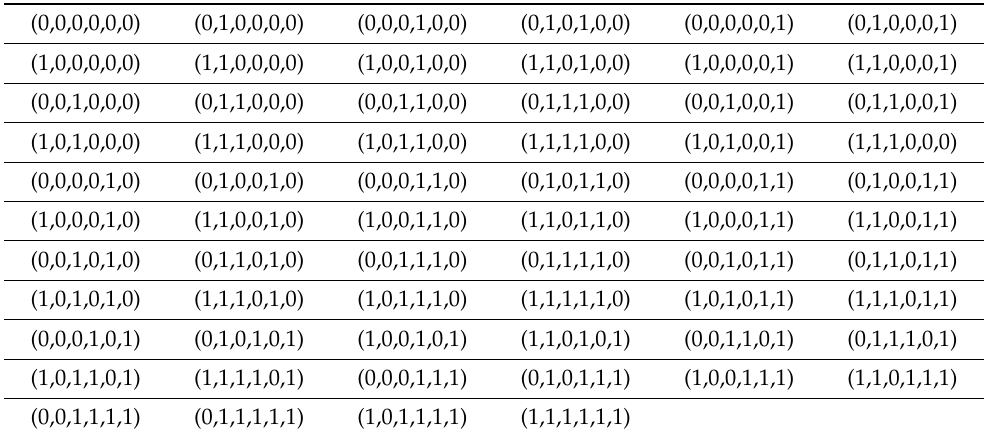
Table 1. Possible game responses.